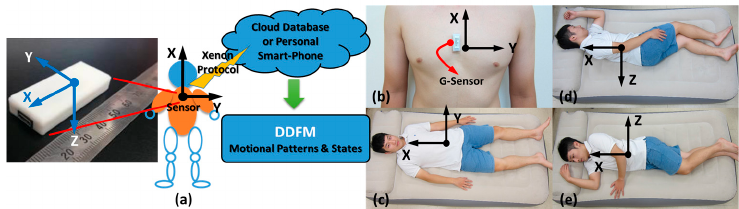
Figure 1. The procedure of data collection is shown in ( a ). The changes in human posture will be detected using the tri-axial gravitational sensor and the collected data will then be transmitted to a personal cloud database. The longest dimension of the sensor is about 4 cm and its weight is about 7 g. ( b ) Shows the related location of the sensor that was directly adhered on a subject’s chest. The directions of sensing axes of the G-sensor were also depicted in each photo of various postures. ( c – e ) Respectively exhibit the analyzed postures from lying face-up, to turning left, and to turning right. Eventually, the posture recognition would be achieved using the proposed data density functional method (DDFM). Appl. Sci. 2018 , 8 , x FOR PEER REVIEW